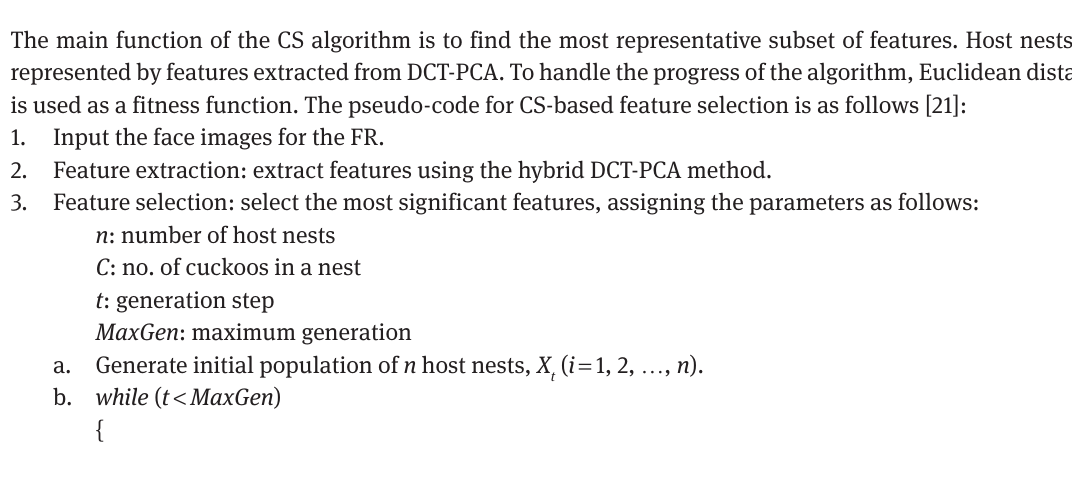
Figure 1 represents the CS algorithm flowchart.